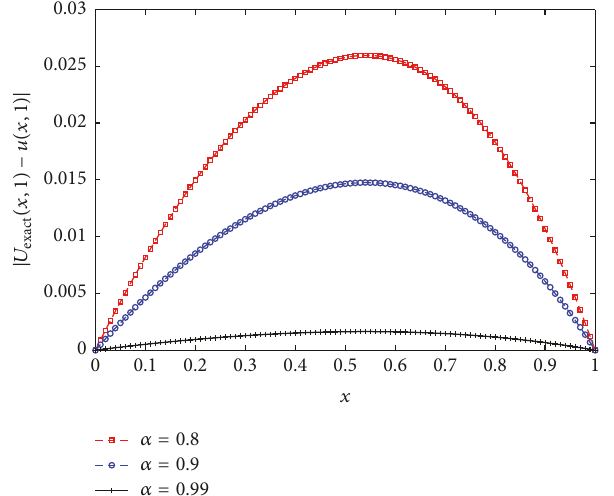
Figure 3: Error norm 𝐿 ∞ for Example 7 ( 𝛼 = 0.8 −◻ ; 𝛼 = 0.9 − ∘ , and 𝛼 = 0.99 − + ) at 𝑇 = 1